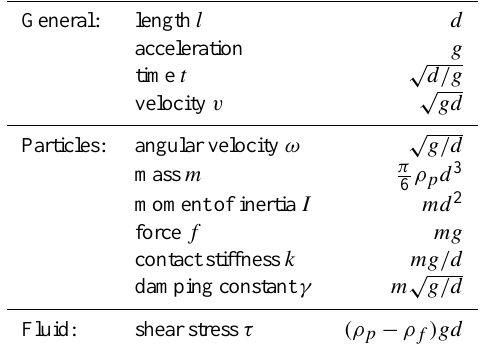
Table 1. Units used in the model, expressed in terms of the grain density ( ρ p ), the fluid density ( ρ f ), the gravity ( g ) and the